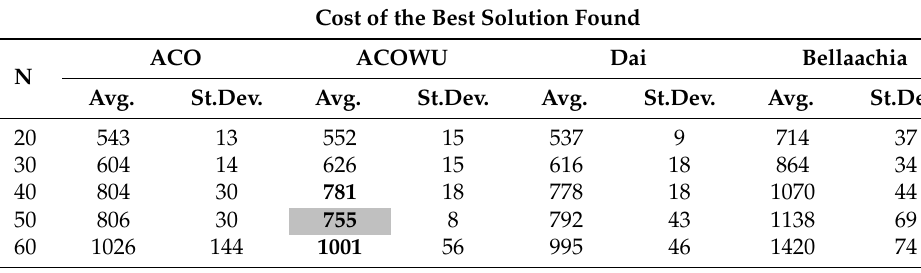
Figure 4. Graph of warehouse used for tests. Table 5. Results obtained in